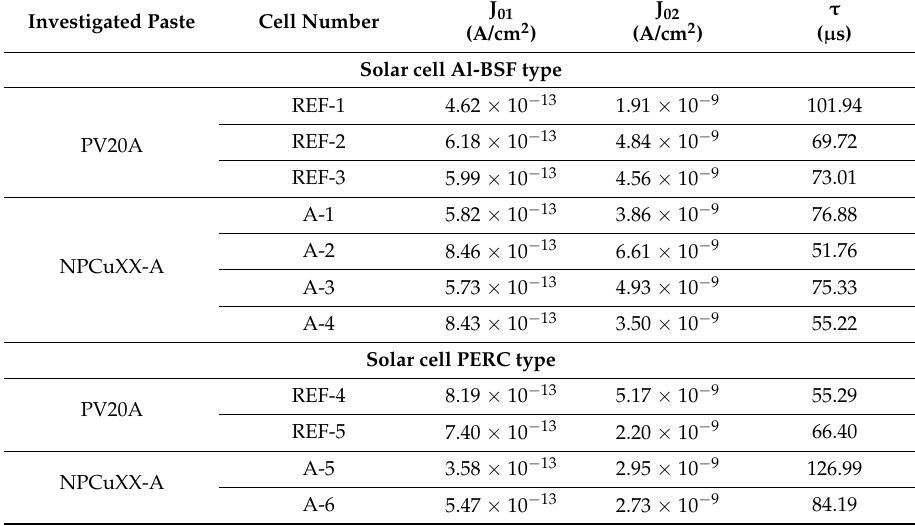
Table 5. Selected electrical parameters of the Cz-Si based solar cells with the highest FF and E ff values with the front electrode applied from the modified NPCuXX paste produced on the ECN part of TNO line in the structure of Al-BSF and PERC compared to the cells produced using the reference